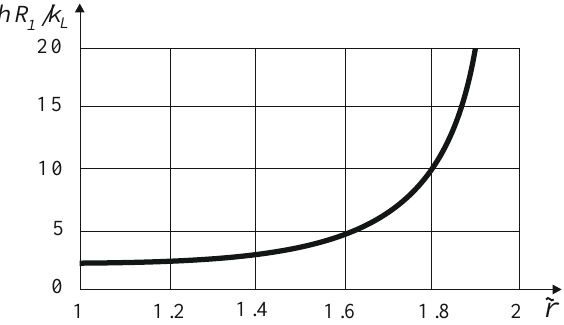
Figure 2. The dependence of the heat transfer coefficient on the position of the solidification front.